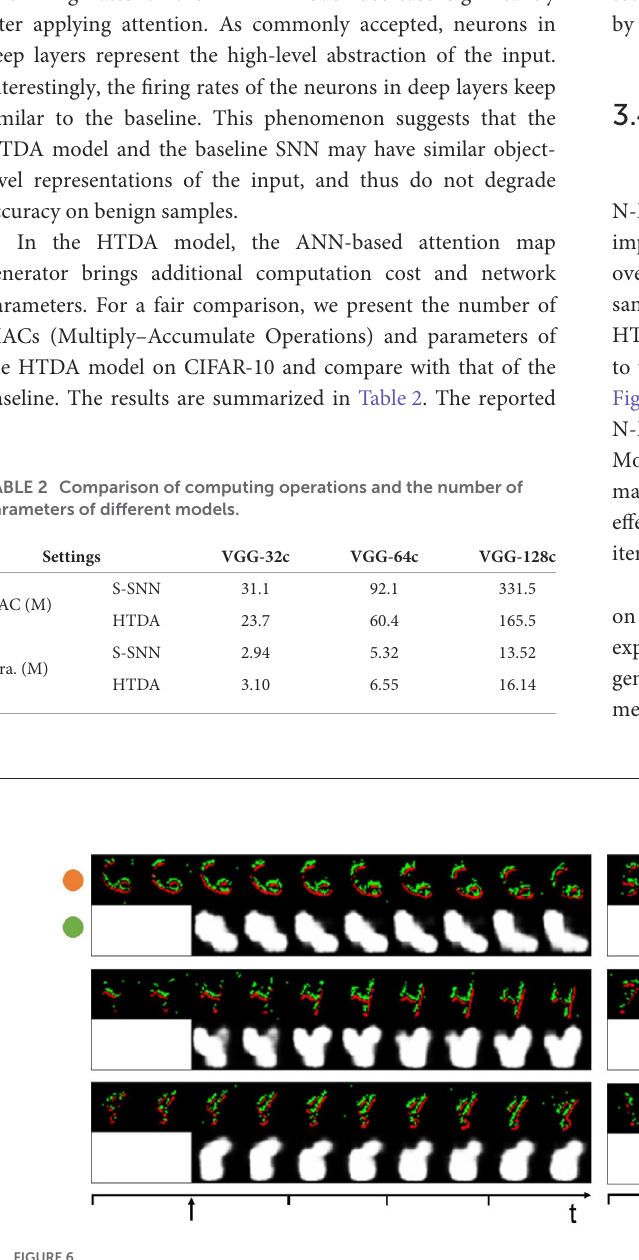
FIGURE6 Event data of samples in N-MNIST and corresponding attention maps. The attention maps are set to all-ones matrices at the first two steps and updated every two